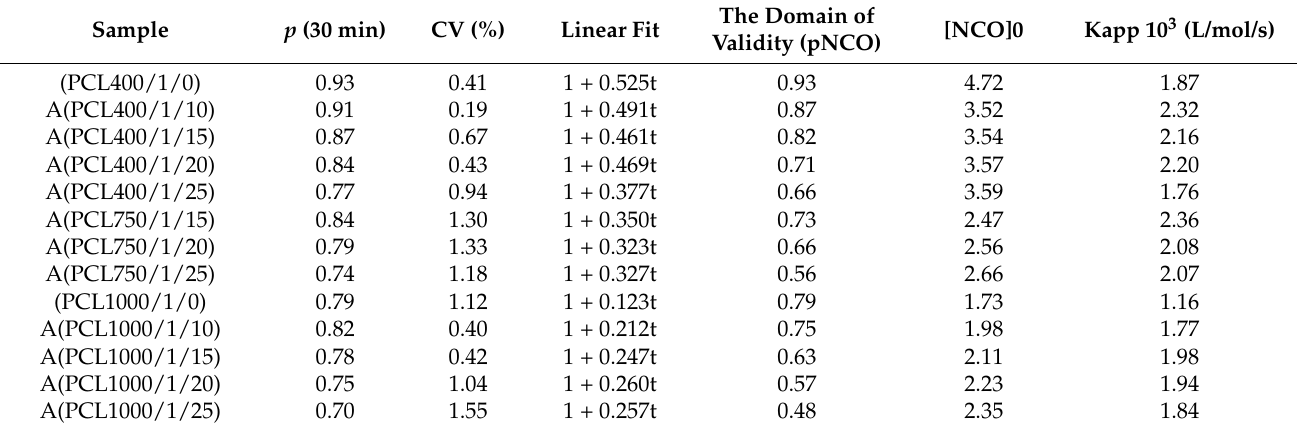
Table 5. Second-order kinetics of lignin-based materials